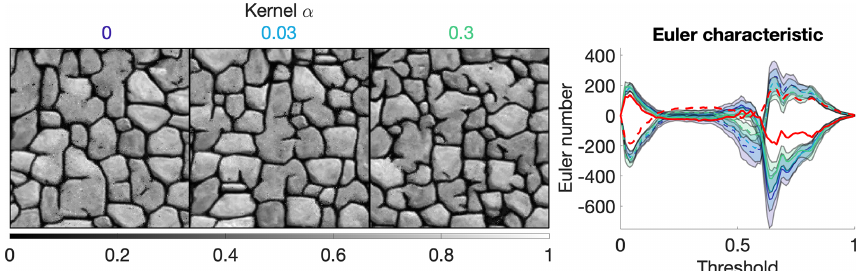
Figure 8. Sensitivity analysis on the kernel parameter α , with fixed parameters k = 1 . 5 and N = 40. The values of the kernels are shown in colors that correspond to the Euler characteristic lines (red is the training image).